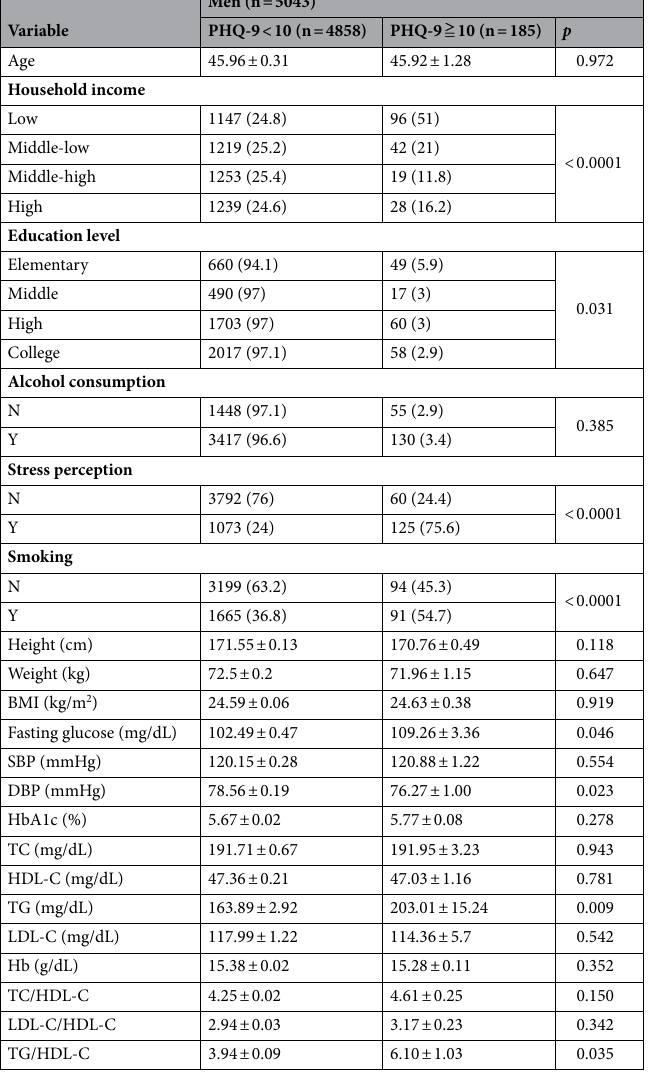
‘Y’ represents current drinkers and ‘N’ represents non-drinkers. Values are presented as number (%) or the mean ± standard deviation. p value was determined through the complex sample Rao–Scott adjusted chi- square test and complex sample generalized linear model T test. PHQ-9 Patient Health Questionnaire-9, BMI body-mass index, SBP systolic blood pressure, DBP diastolic blood pressure, HbA1c hemoglobin A1c, TC total cholesterol, HDL-C high density lipoprotein cholesterol, TG triglyceride, LDL-C low density lipoprotein cholesterol, Hb